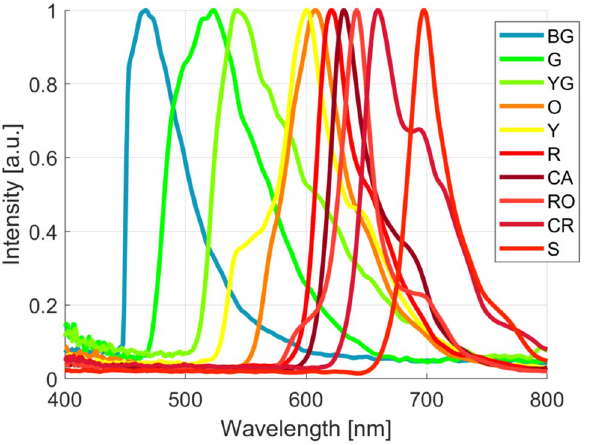
Figure 10. Average spectra of each fluorescent bead sample using full sampling of N=1000 and He-Ne correction. BG: blue-green, G: green, YG: yellow-green, O: orange, Y: yellow, R: red, CA: carmine, RO: red- orange, CR: crimson, and S: scarlet.